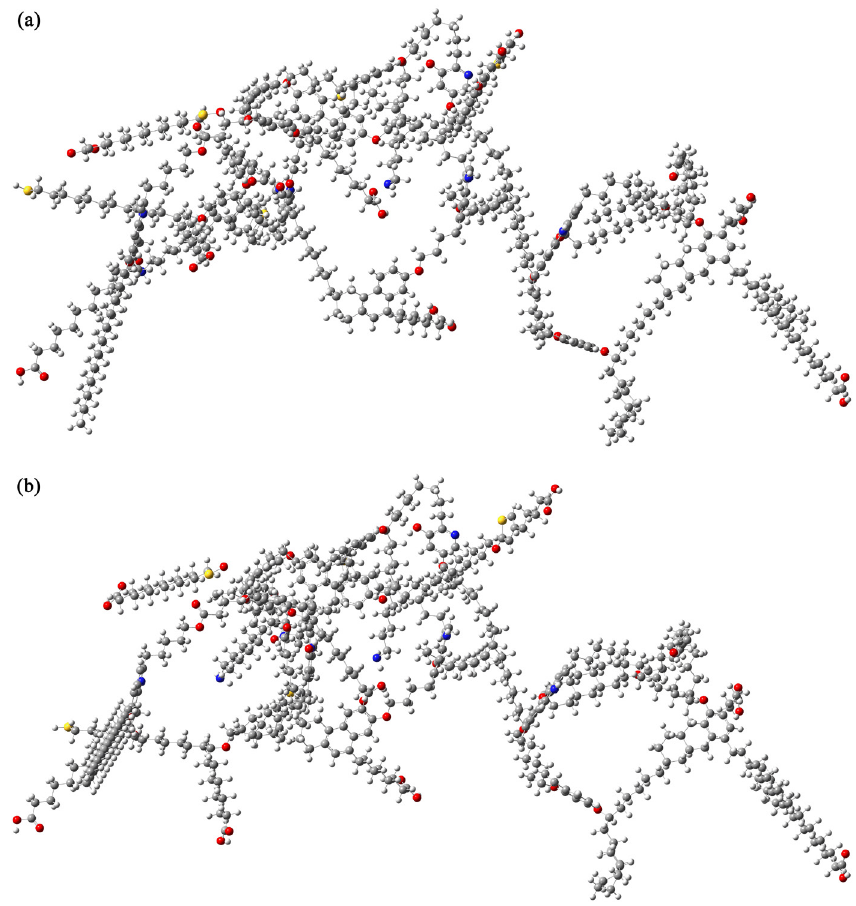
Fig. 3. 3D molecular model of Dachengzi oil shale kerogen before (a) and after (b) geometry